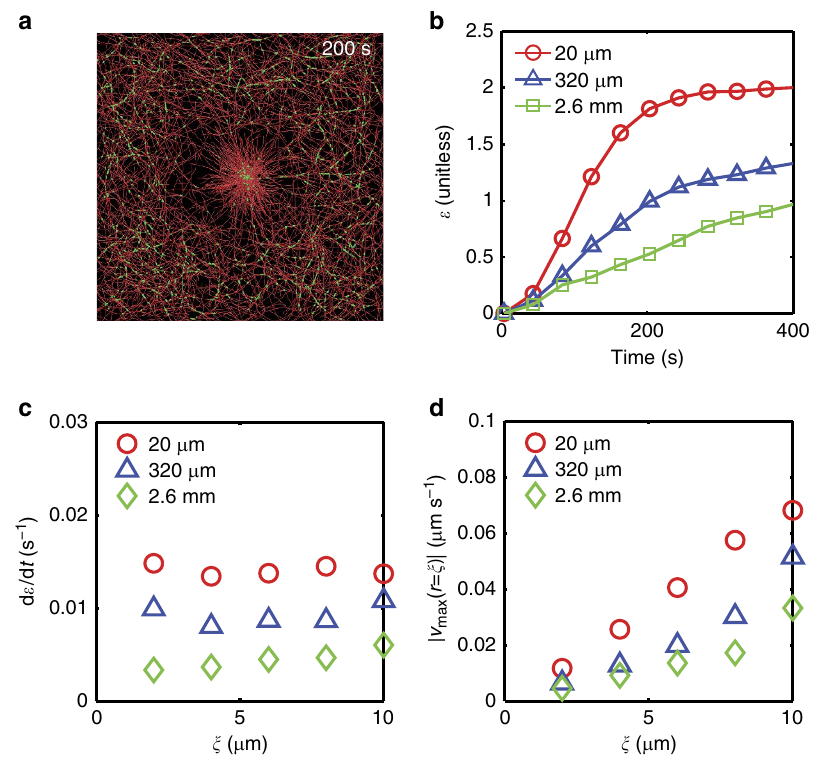
Figure 6 | F-actin bending does not underlie telescopic contractility. ( a ) Agent-based simulation of F-actin (red) with mean and persistence length ( l p ) are 7.1 m m and 20 m m, respectively, and myosin motors (green) during contraction at 200s. The width of the image is 40 m m, and the radius of the activation area is 6 m m. Myosin has lower off-rate within the activation area than outside the activation area. ( b ) Strain over time for three different persistence lengths, l p ¼ 20 m m, 320 m m and 2.6mm. ( c ) Strain rate and ( d ) velocity as a function of the diameter of the activation region in actomyosin networks with different l p . See Supplementary Table 2 for a list of model